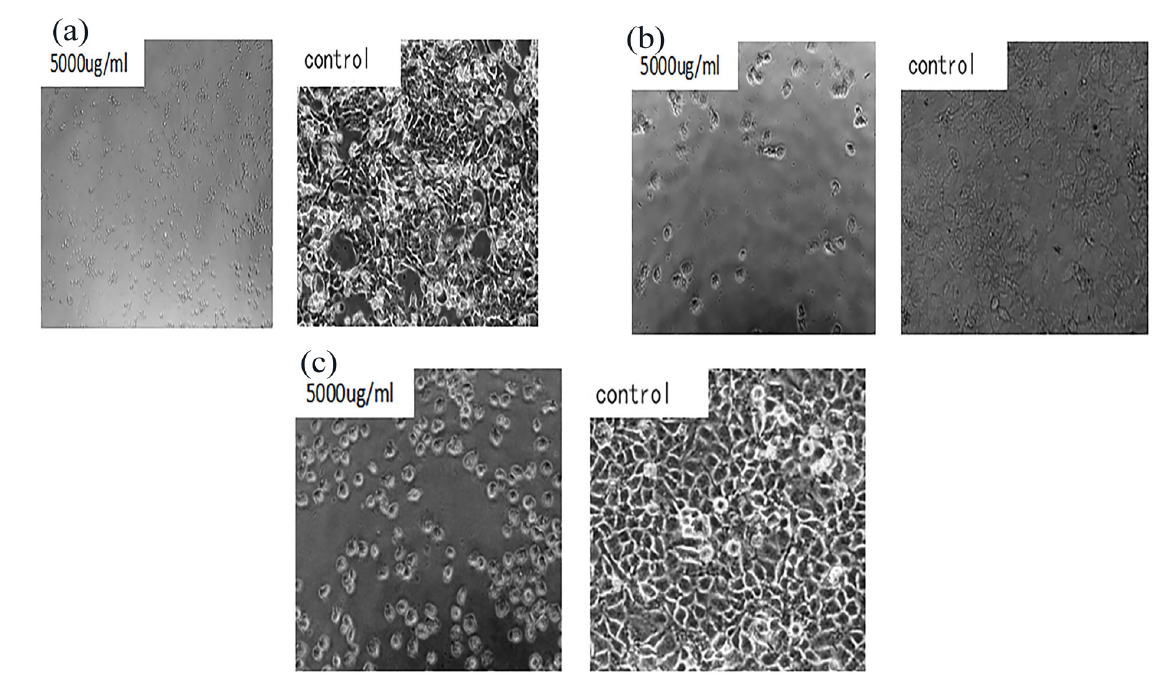
Figure 6. The cell morphology of HCT-116(a), Huh-7(b) and SMMC-7721(c) cells after 24 h of